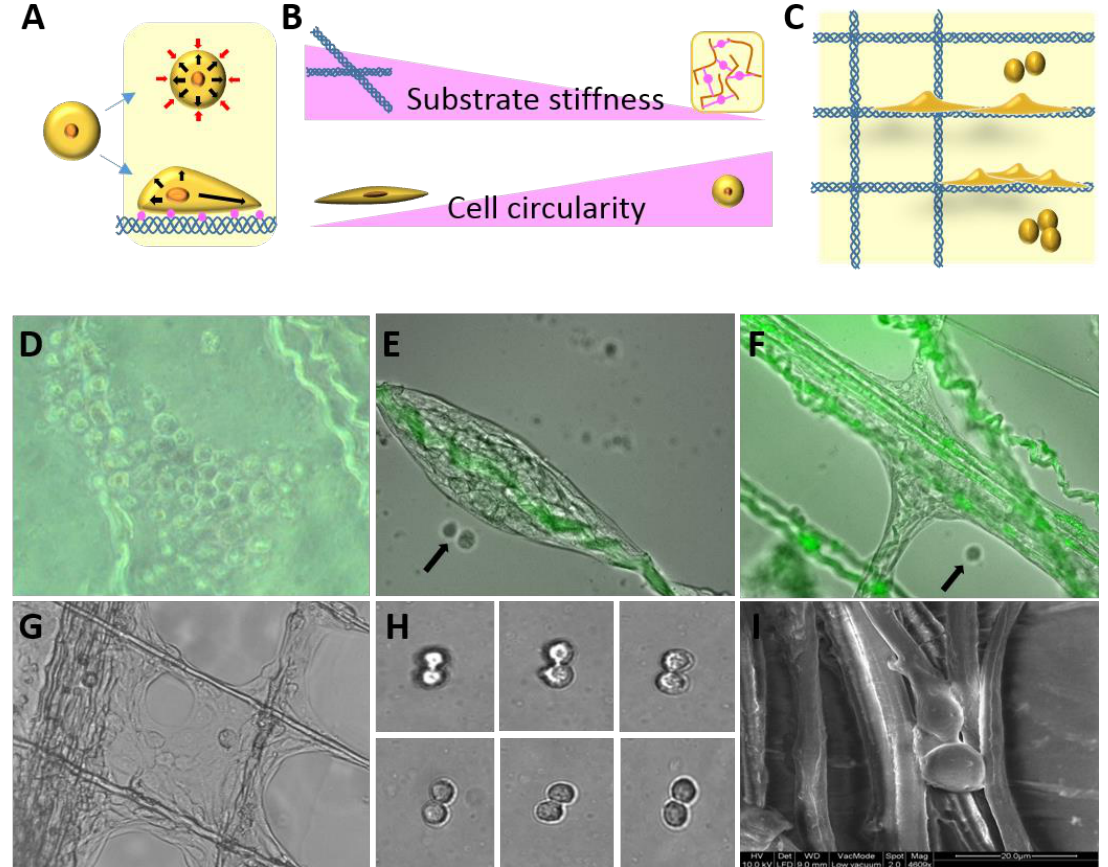
Figure 2. The effect of microenvironment stiffness on cell morphology and growth: scheme showing the morphological effect of differential mechanical forces affecting cells growing on a 2D high-stiffness surface or in a 3D low-stiffness matrix ( A , B ). Cell morphology of cells cultured in a collagen-alginate biocomposite ( C ). Light microscopy of cells cultured in a biocomposite, growing in the alginate before reaching a fiber (magnification ×200, D ). Light and/or fluorescent microscopy of cells forming tissue like structures while cultured in the collagen fiber (green) embedded in alginate biocomposite, (magnification ×200 and 400, E – H ). Phase contrast picture of dividing cells in the alginate (magnification ×400, H ) and SEM image of dividing cells on the collagen fibers (magnification ×4600, I ).